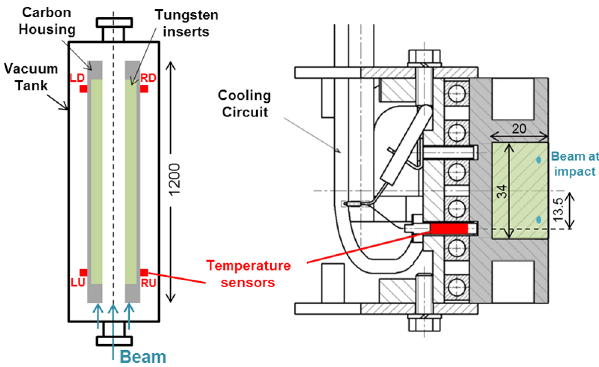
FIG. 5. Schematic diagrams of a standard horizontal tertiary collimator. Top view (left picture) and front view (right picture) of the cross-section of the left jaw assembly. The position of the jaw temperature sensors (left upstream (LU), left downstream (LD), right upstream (RU) and right downstream (RD)) is indicated. All dimensions are in mm.